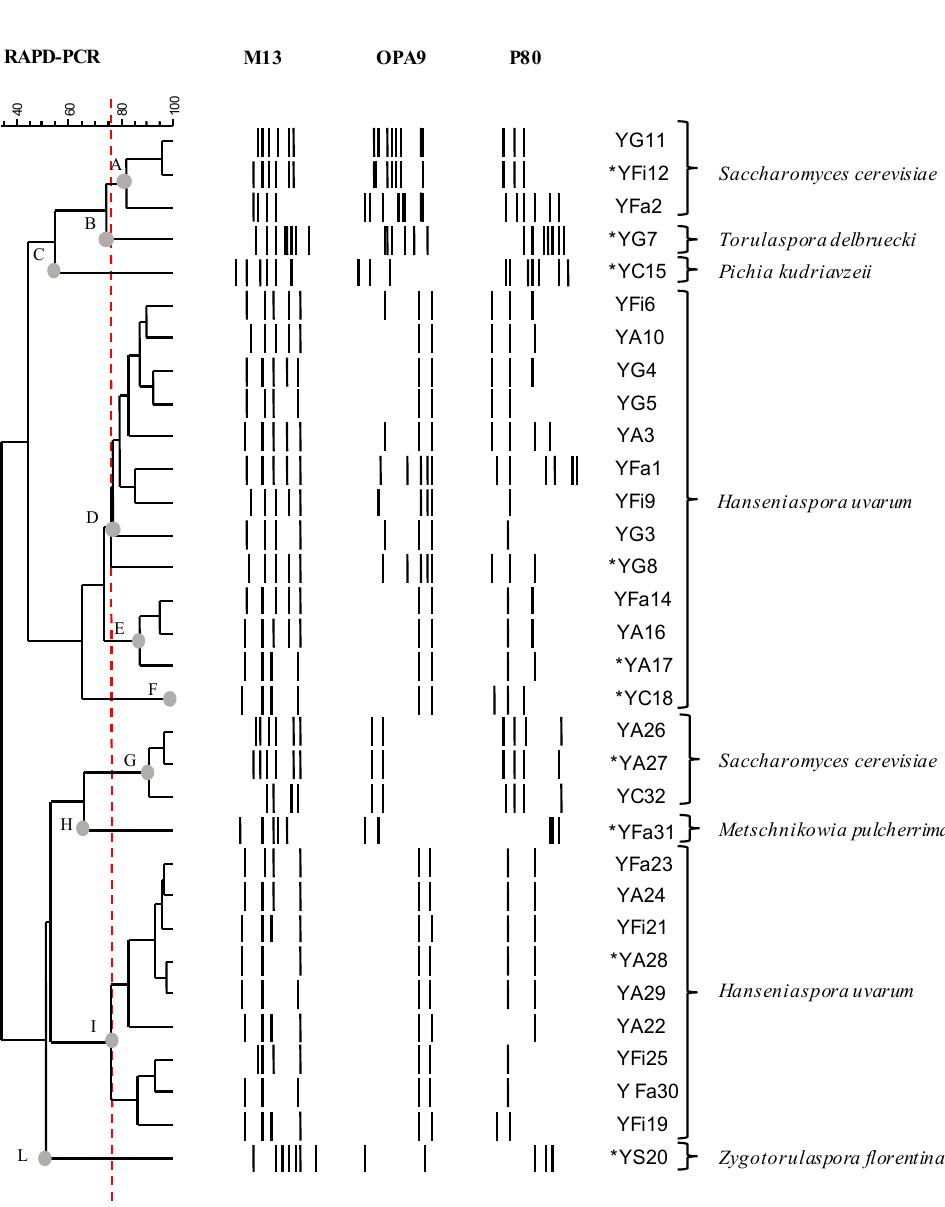
Figure 1. Dendrogram showing the similarity among RAPD-PCR profiles of 32 yeasts that were isolated from different wine-associated sources. The asterisks (*) indicate the strains that were identified by 26S rRNA sequencing analysis. The identification, based on blast comparison in GenBank, was reported in Table S1. Most yeasts were isolated from must and, to a lesser extent, from grapes of different varieties from the Campania Region. Almost all strains lacked decarboxylase activity, with the exception of four strains of S. cerevisiae , one of Torulaspora delbrueckii , and one of Zygotorulaspora florentina . The commercial strain S. cerevisiae LSC, used for comparison in dough fermentations, showed no potential decarboxylase activity against the amino acids that were tested. In this context, qualitative screening of decarboxylase activity becomes of technological interest to identify yeast strains that are potentially able to produce biogenic amines (Bas). In general, biogenic amines, mainly formed by microbes producing amino acid decarboxylase, are widely found in different foods such as meat, fish, cheese, and wine [26,27]. However, recent studies have also found detectable levels of BAs in sourdoughs where yeasts and lactic acid bacteria can contribute to the BAs formation